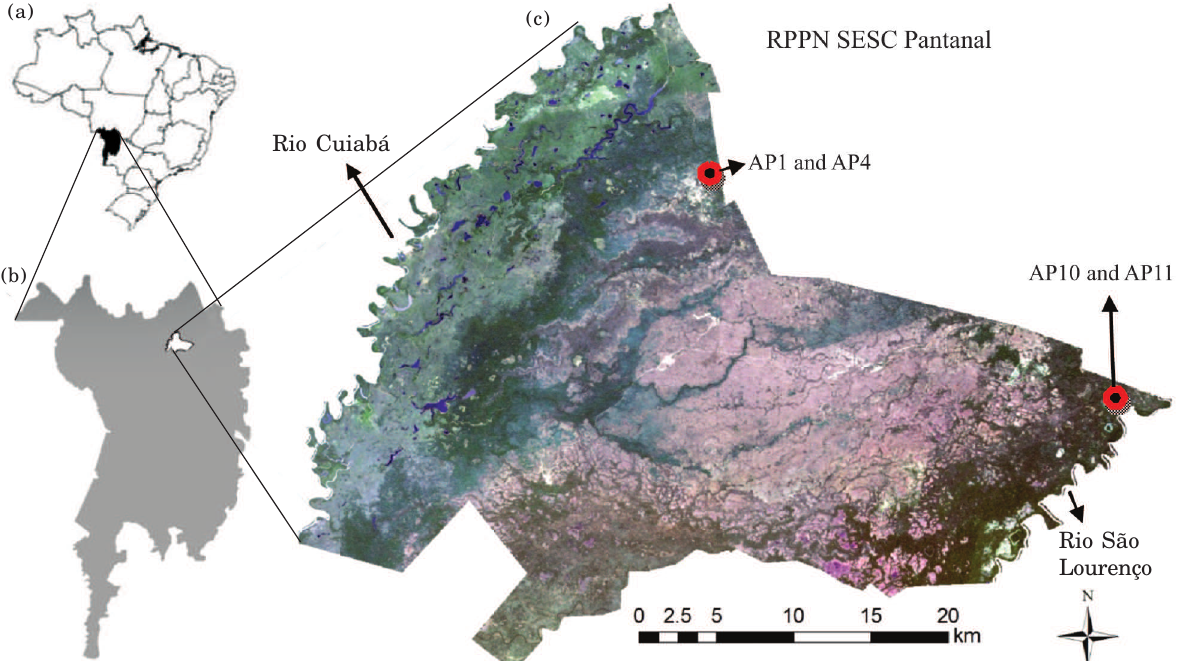
Figure 2. Study site in the Northern Pantanal. (a) location of the Pantanal region in Brazil; (b) study site in the Pantanal; (c) location of soil profiles in RPPN SESC Pantanal - SPOT